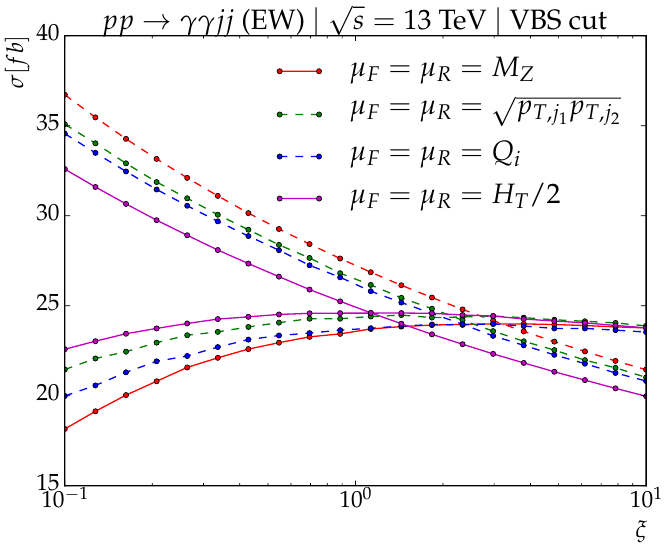
Figure 2 . Scale dependence of the LO and NLO cross sections for the EW-induced